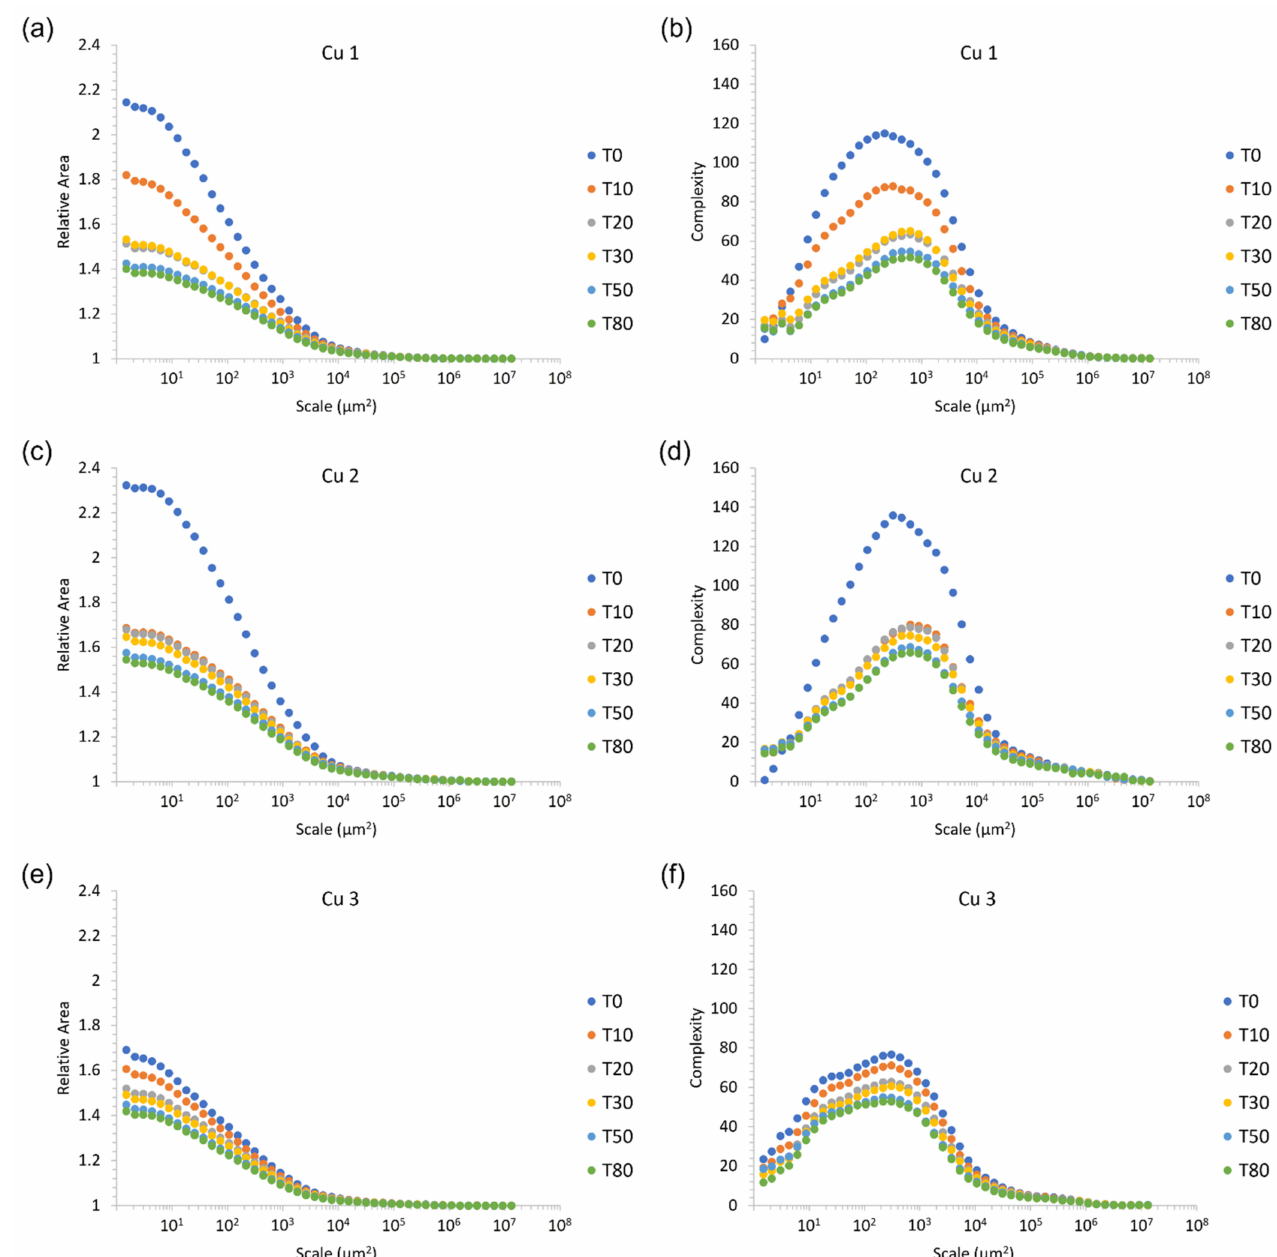
Figure 4. Surface evolution as a function of finishing time for each of the 3 Cu powders. ( a , c , e ). Relative area as a function of finishing time, ( b , d , f ). complexity as a function of finishing